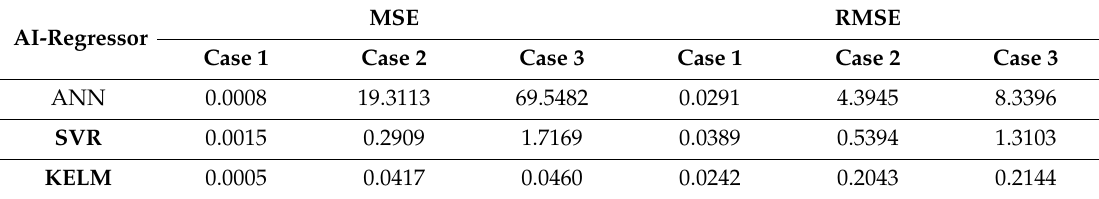
Table 2. Obtained Mean Squared Error (MSE) and Root Mean Squared Error (RMSE) in the AI test. AI-Regressor